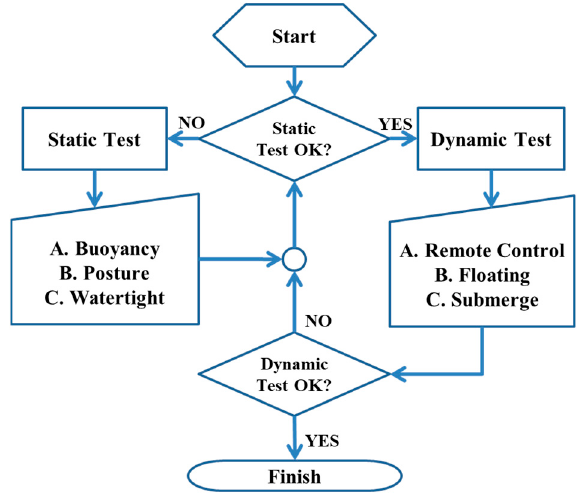
Figure 12. Flow of fundamental tests before the experiment.